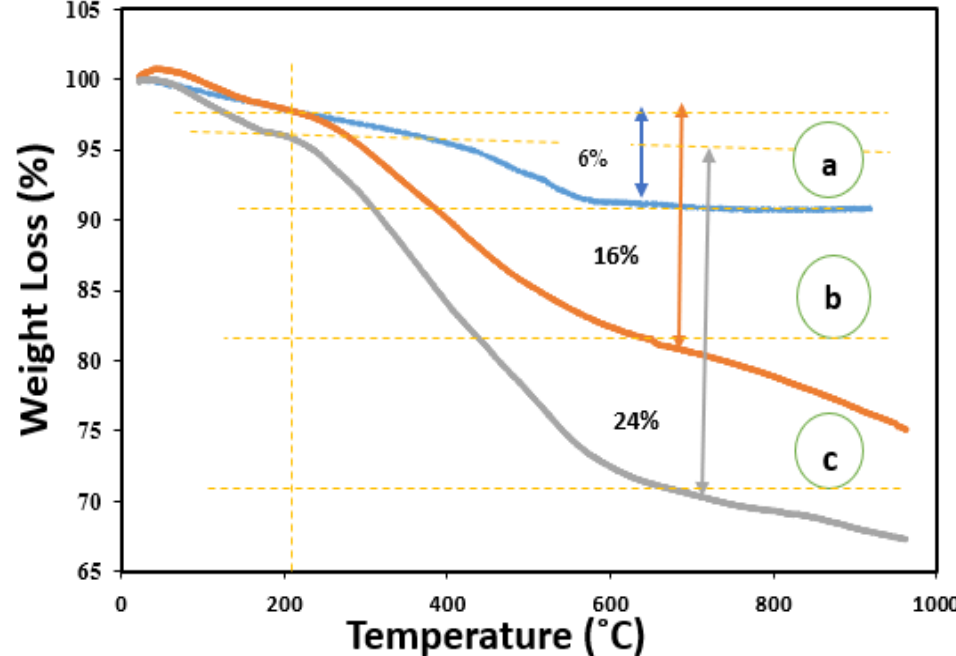
Figure 6. TGA curves of ( a ) SBA-Pr-Cl, ( b ) SBA-Pr-Is, and ( c )